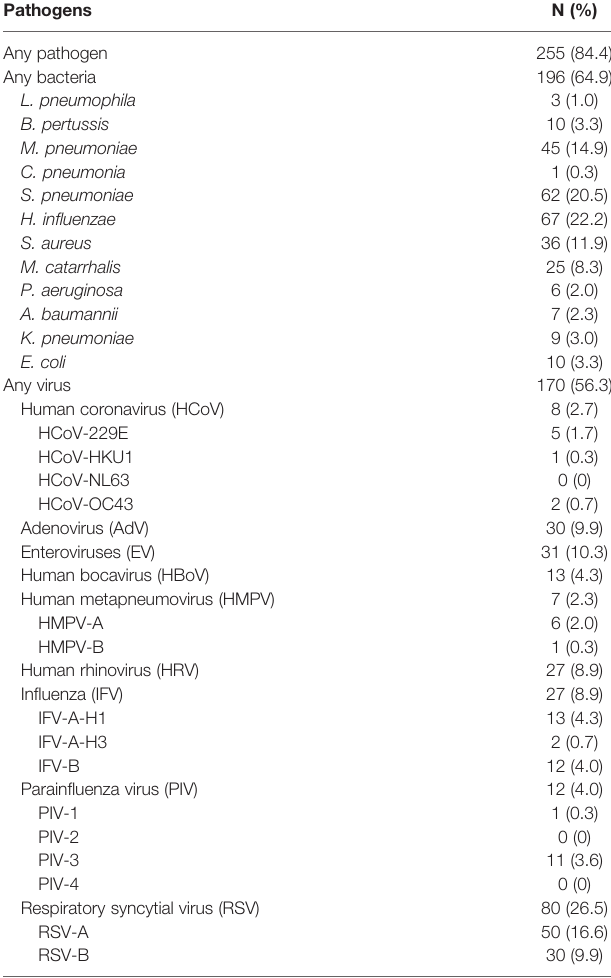
TABLE 2 | Detection rate of common respiratory pathogens with combined-MS methods (n = 302).